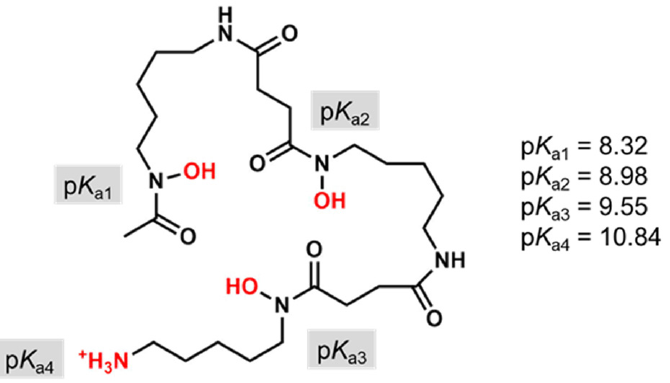
Figure 1. Chemical structure and p K a values of H 4 DFO. Deprotonation sites are highlighted in red. Summers et al. recently proposed that volatilized Zr-DFO complex salt forms 8-coordinated Zr with oxygen ligands, and the chemical formula should be Zr(DFO)(OH) 2 as the results of an extended X-ray absorption fine structure (EXAFS) study [10]. On the other hand, the complex structure of Zr-DFO in aqueous solution and their stability con- stants are also important for RCY evaluation 89 Zr-DFO-mAb. The stability constants of the Zr-DFO complex are defined by the following equation (charges are omitted for clarity):